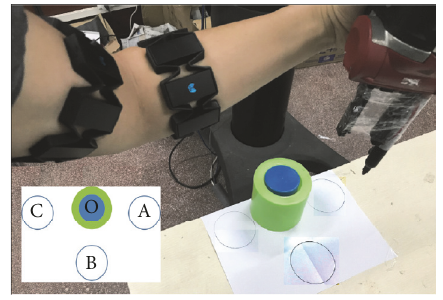
Figure 5: A scene captured in the experiment.